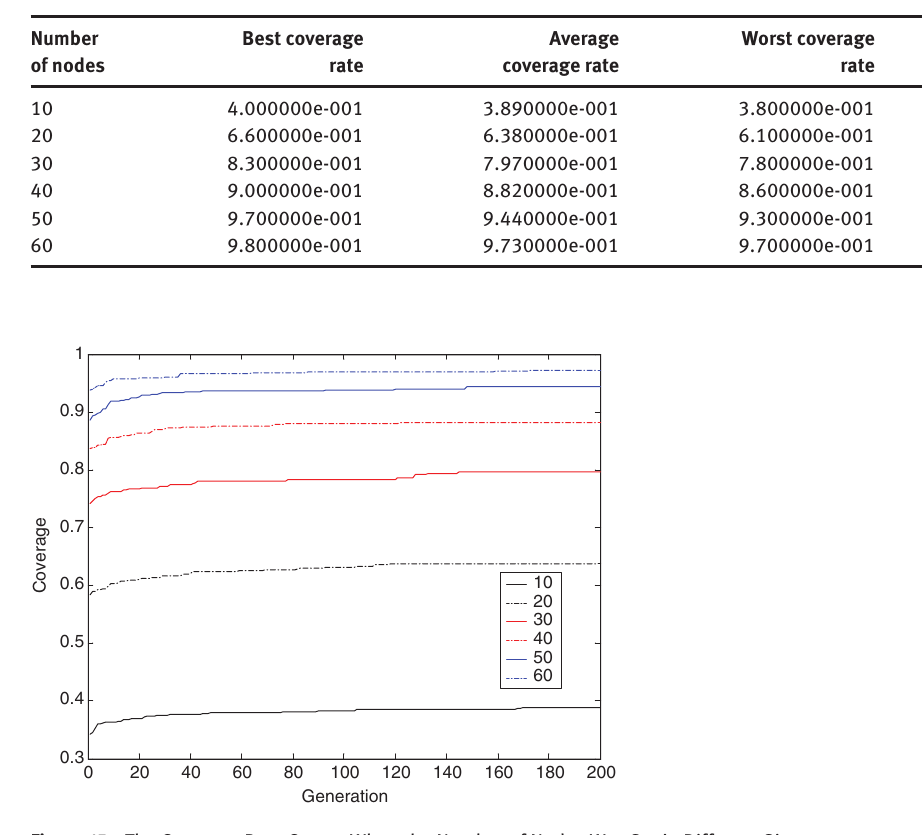
Table 5: The Statistical Results about the Influence of the Number of Nodes on Coverage Performance.